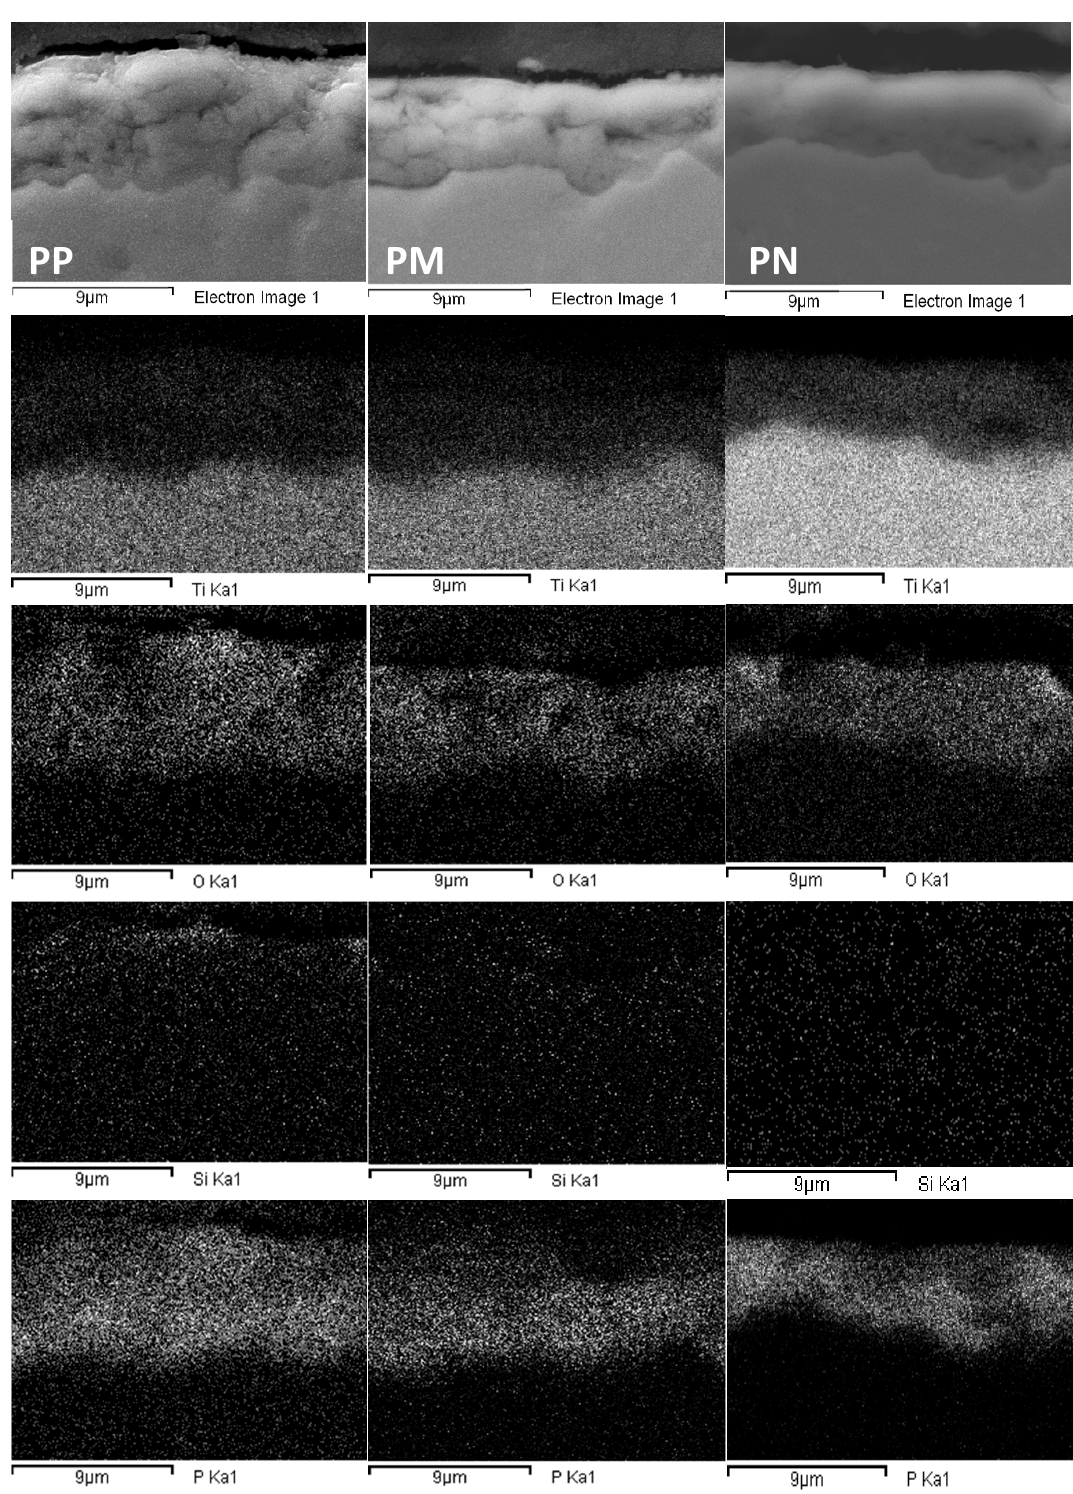
Figure 4. Polished cross sections and EDS X-ray maps of single layer PEO coatings obtained in pulsed DC (phosphate bath): PP (left column), PM (centre column) and PN (right column). The duty cycle increases on going from left to right (Table 1). The X-ray maps were recorded for each coating in the same area of the electron image in the top row.